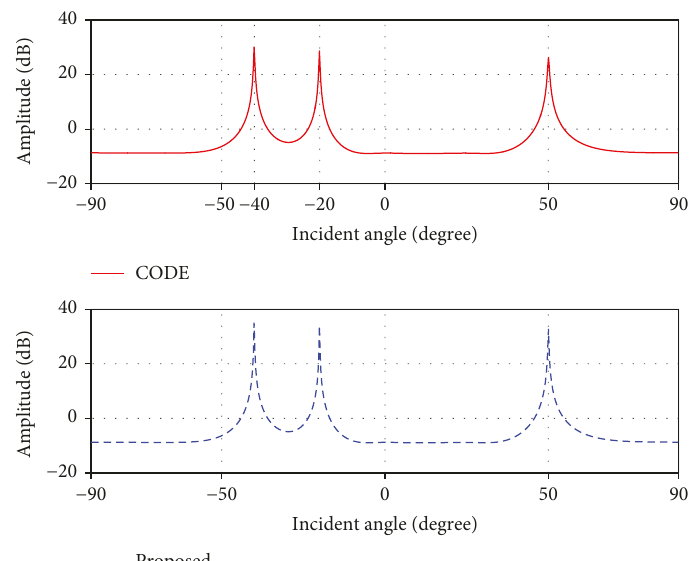
Figure 2: MUSIC spectrums by CODE and proposed, half-wavelength ULA, N = 4 , T = 200 , and SNR = 10dB , 3 sources at θ θ = − 30 ° , and θ = 40 ° . 2 3